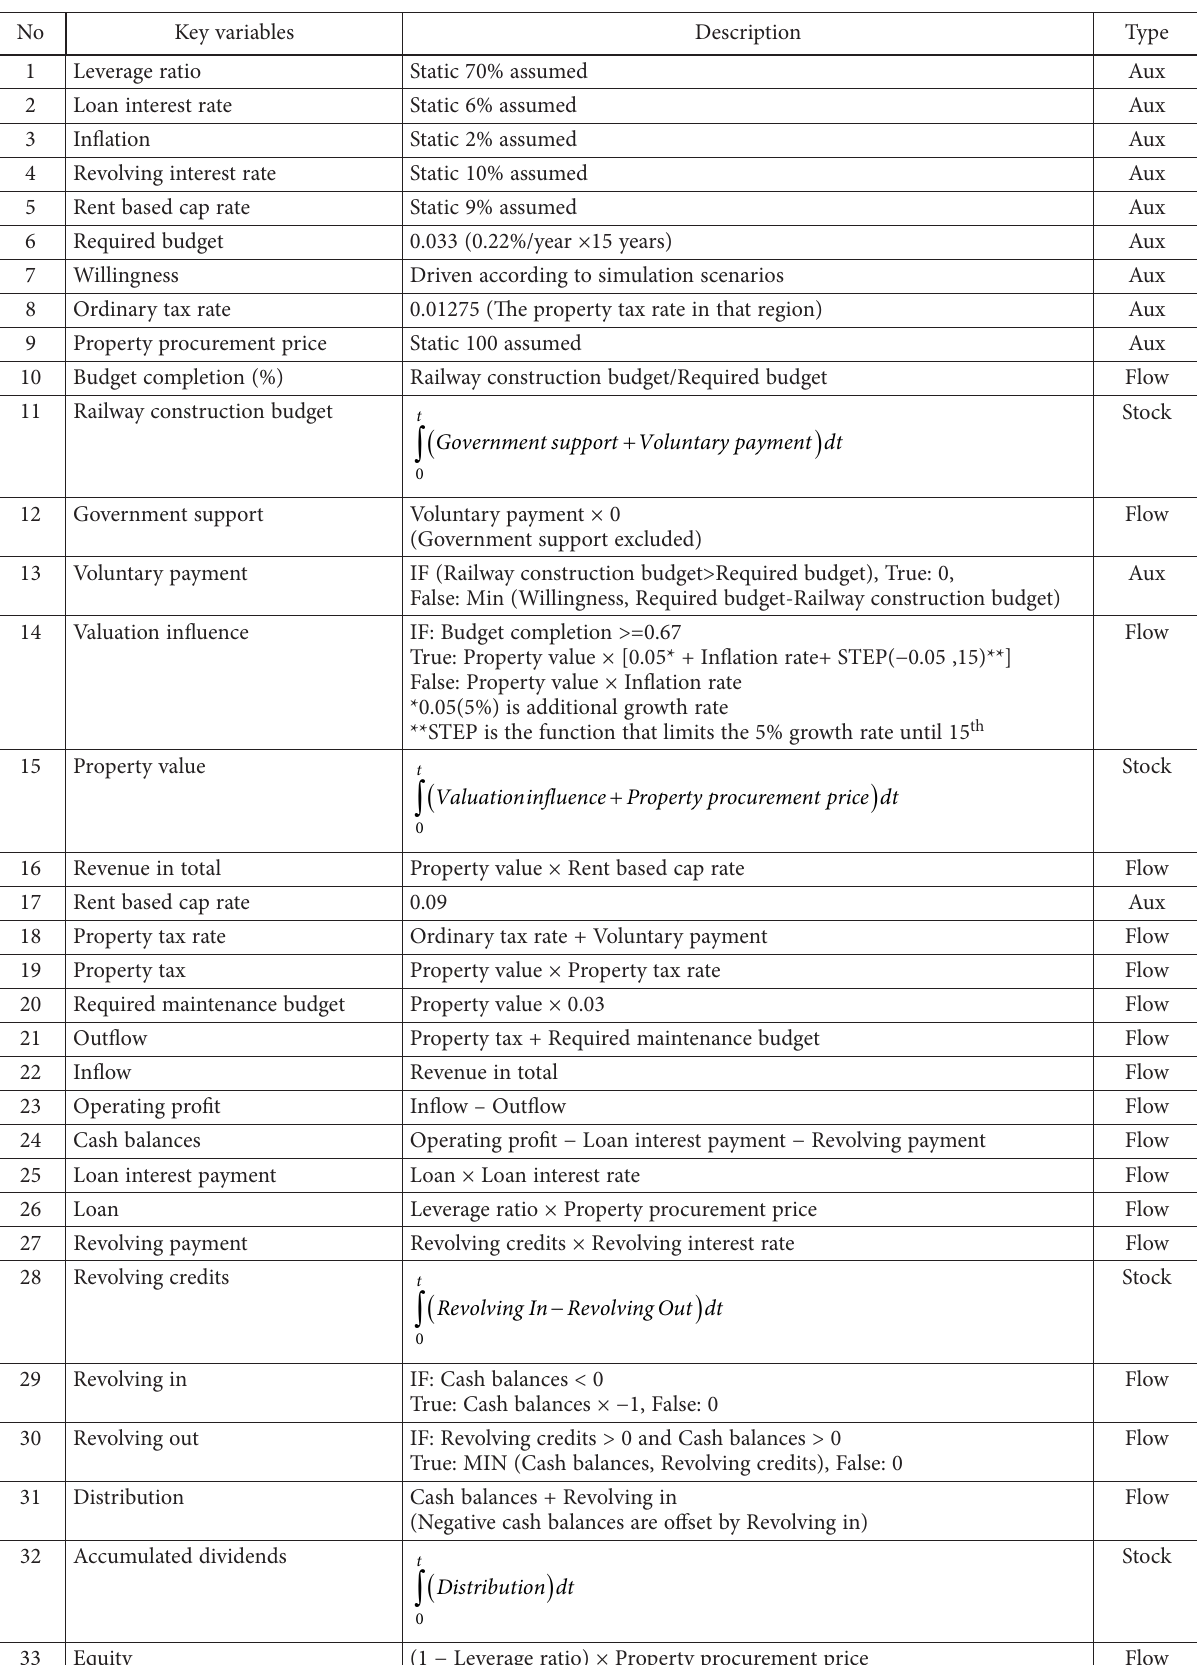
Table 3. Key variable